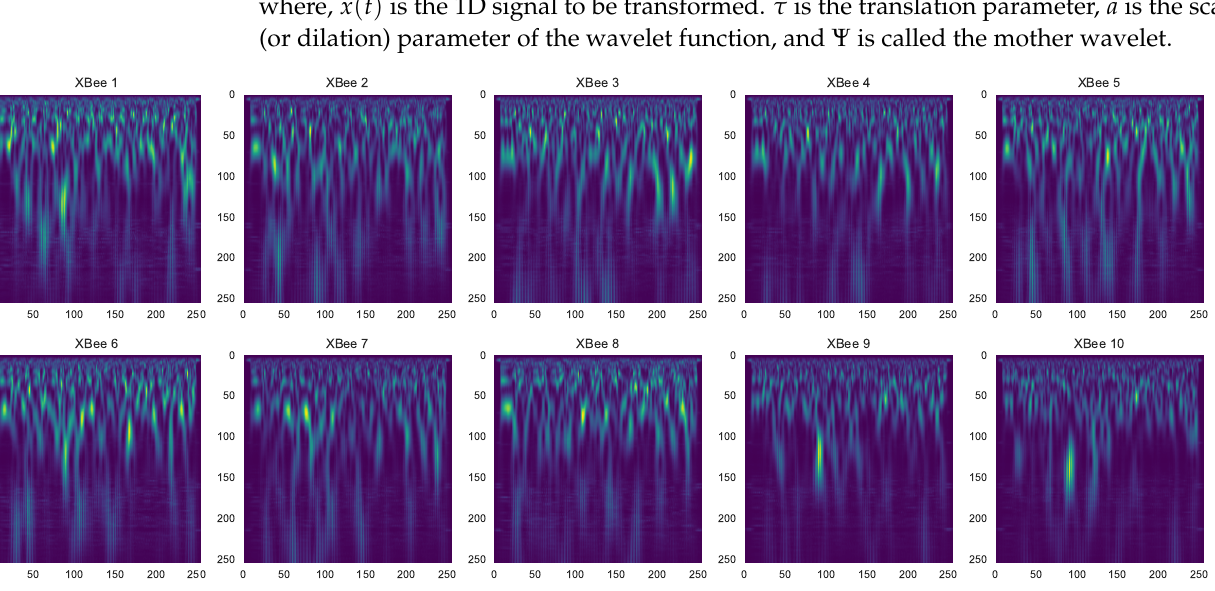
Figure 2. CWT of each XBee transmitter.